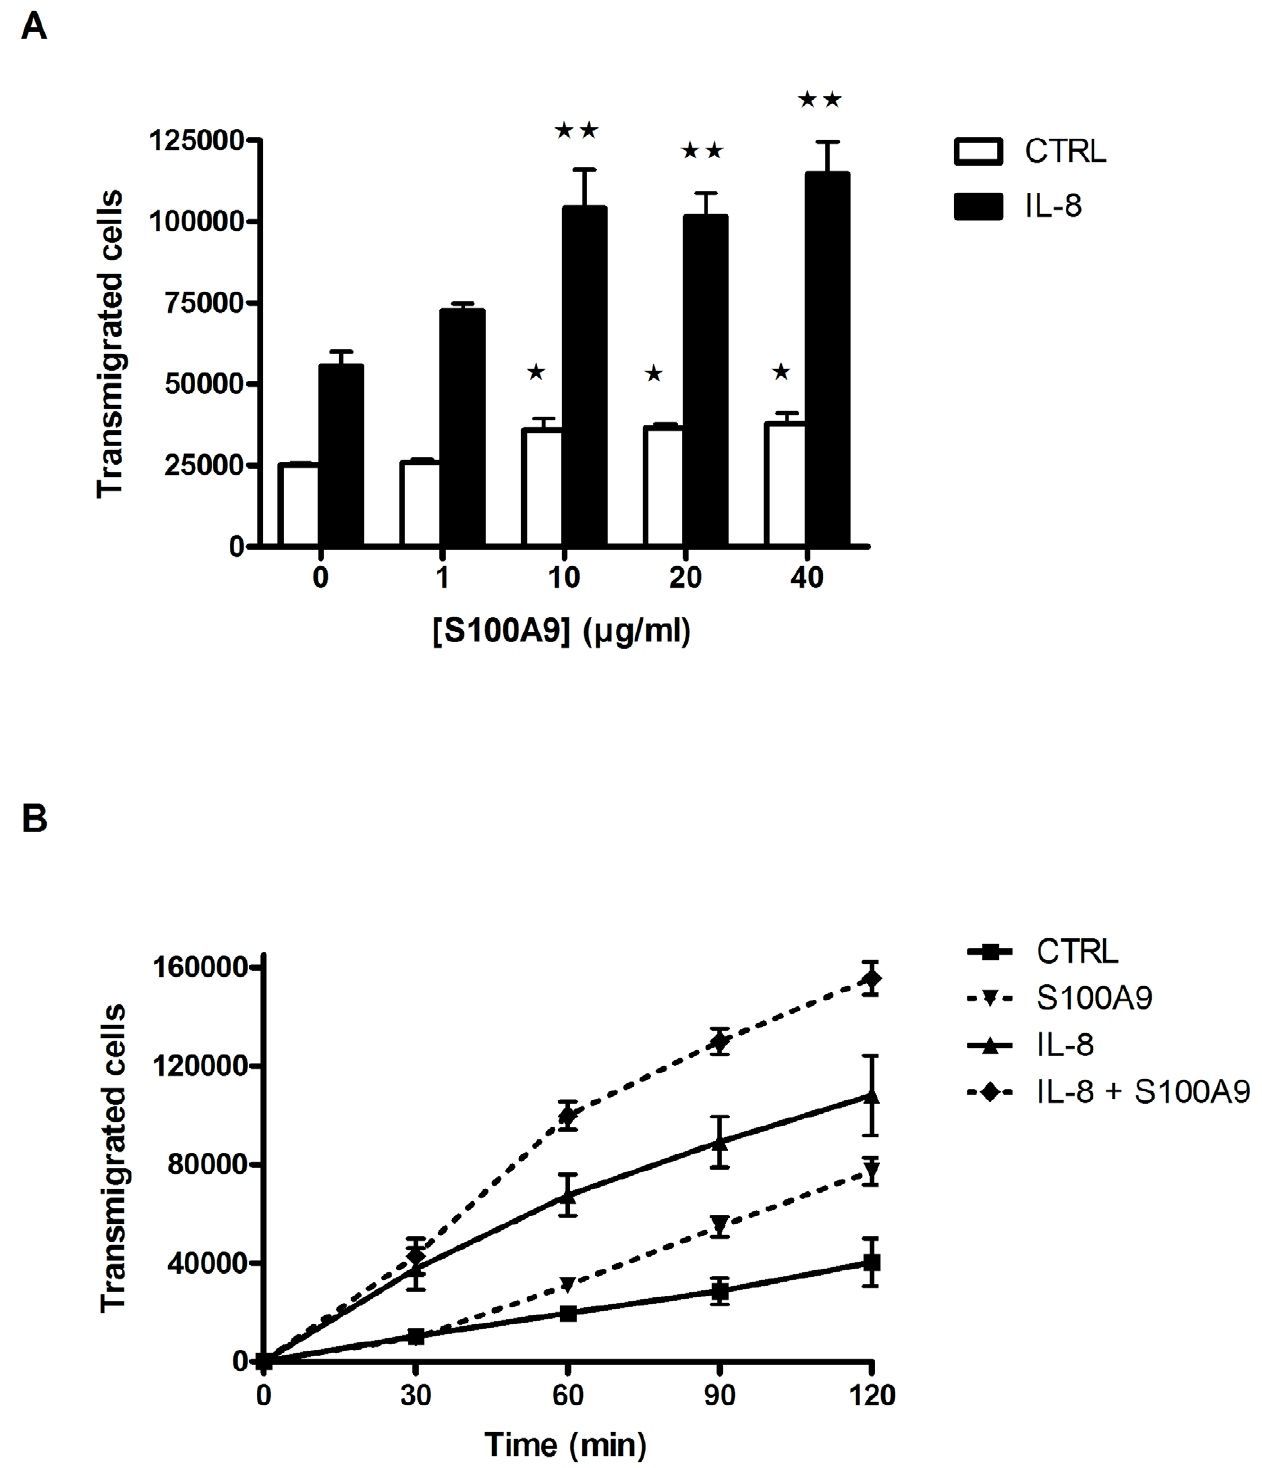
Figure 6. Neutrophil migration across HUVECs in response to S100A9. A) Increasing concentrations of S100A9 were added in the upper wells with neutrophils. IL-8 (5 ng/ml) or buffer was added to the lower wells and neutrophils were allowed to migrate for 2 h at 37 u C. Data are the mean 6 SEM of 3 experiments using neutrophils from different donors. *p , 0.05, **p , 0.01, one-way ANOVA, Dunnett’s multiple comparison test. B) S100A9 prolongs the time for neutrophil migration across endothelial cells. S100A9 (40 m g/ml) was added to the upper well with neutrophils. IL-8 (5 ng/ml) or buffer was added to the lower well and every 30 min for up to 2 h the upper wells were moved to new lower wells. The number of transmigrated cells was determined as described in Materials and Methods. Data shown represent the mean 6 SEM of at least 3 experiments using neutrophils from different donors.